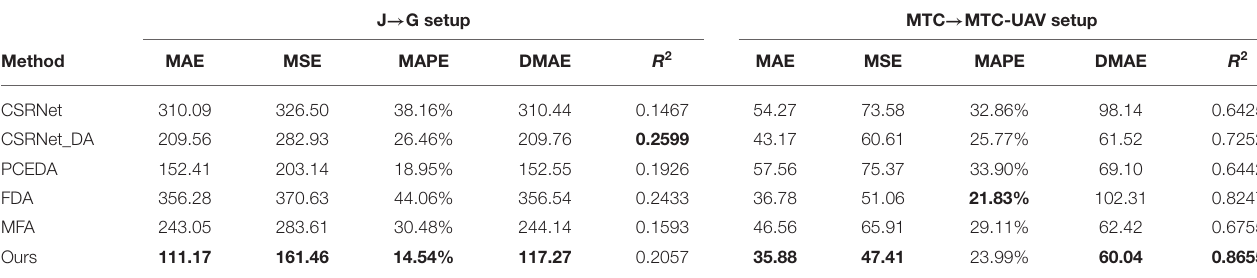
TABLE 4 | Quantitative comparisons under J → G setup (RPC dataset) and MTC → MTC-UAV